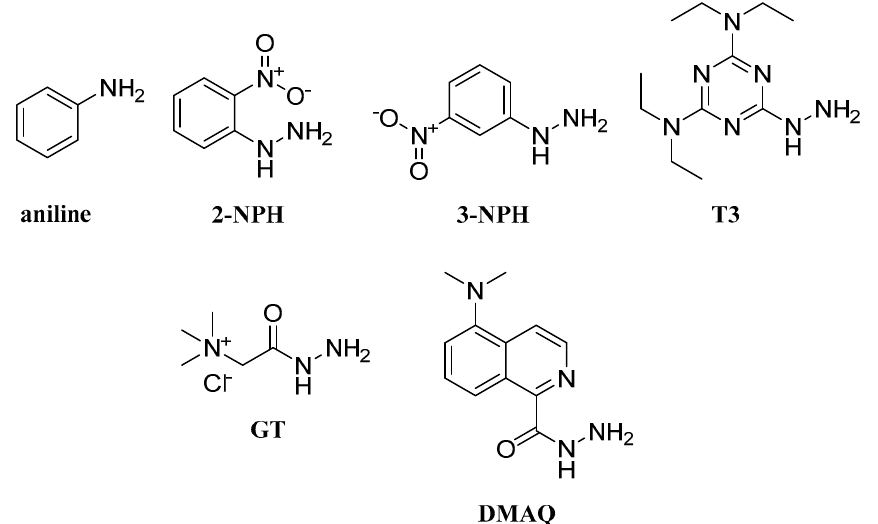
Figure 6. Aromatic amines, hydrazines and hydrazides as derivatization reagents for LC-HRMS analysis of FFAs.